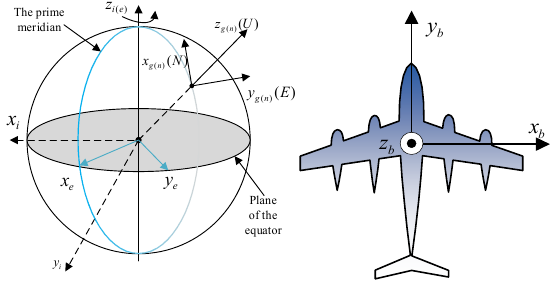
Figure 1. Diagram of the relationship between coordinate